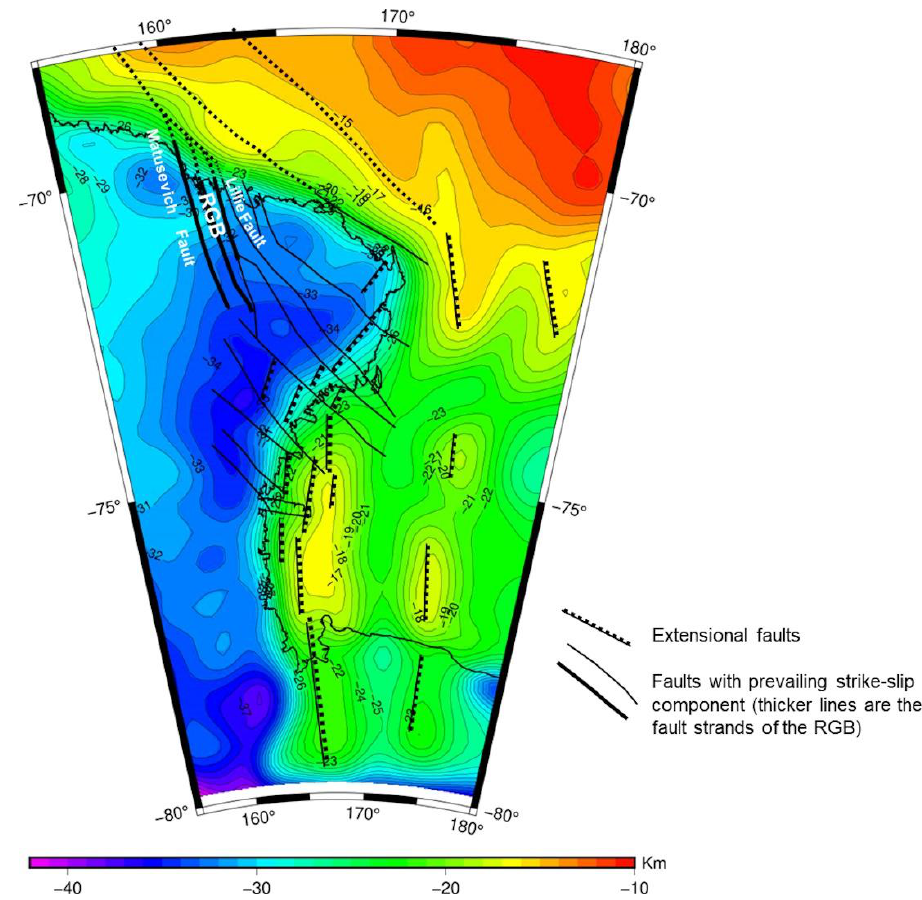
Figure 5. The estimated Moho depth in the Ross -TAM region derived from the inversion of gravity data and known Moho depth from the combined dataset of Pappa et al. [26]. The gravity disturbance used in the computation is upward continued to a reference height of 50 km.